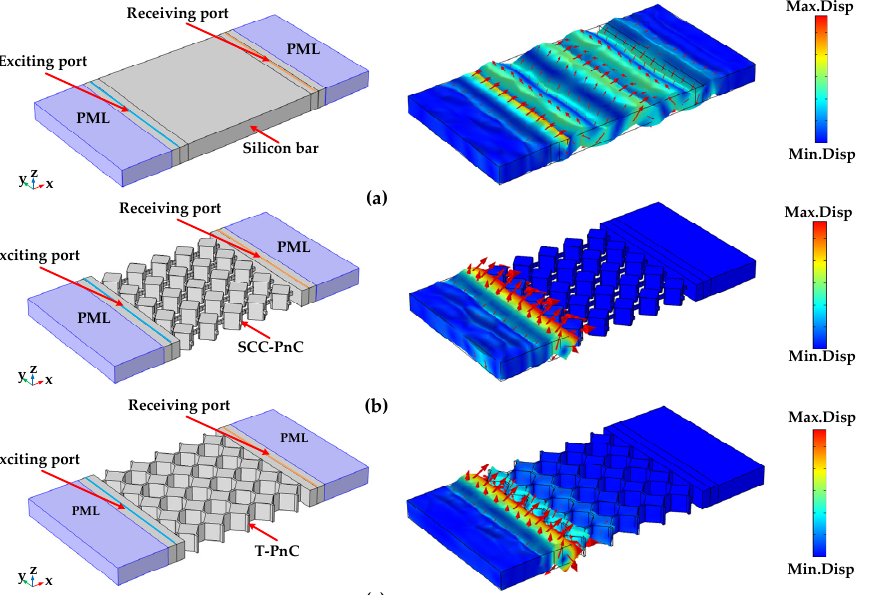
Figure 5. Comparison of total displacement amplitudes of ( a ) reference group delay line, ( b ) SCC-PnC delay line, and ( c ) T-PnC delay line at 149.66 MHz (The arrow represents the size and direction of the displacement).